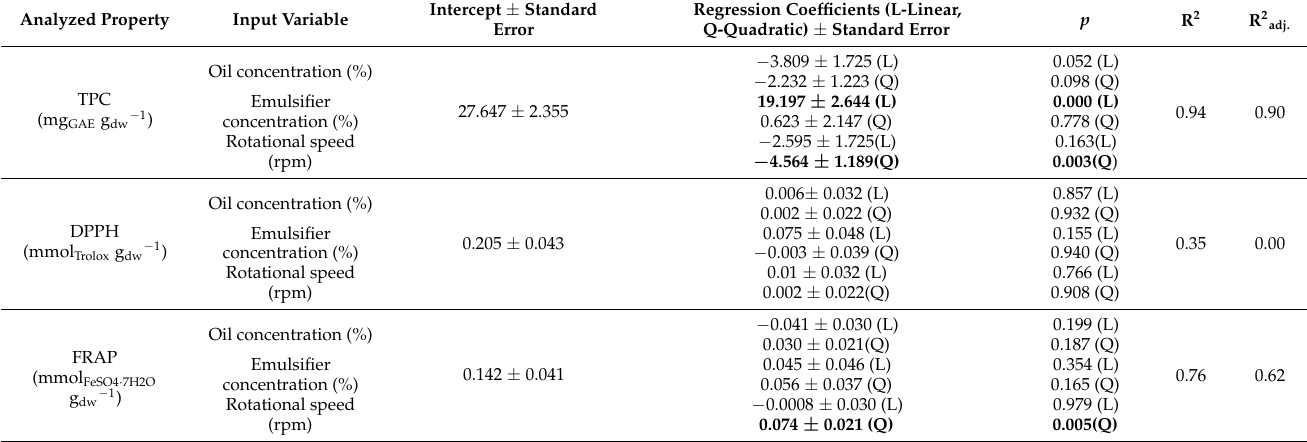
Table 3. Response surface models regression coefficients and determination coefficients for chemical properties of oil-in-water emulsions containing rosemary extract with the addition of commercial pea protein as an emulsifier (bold values: p < 0.05).